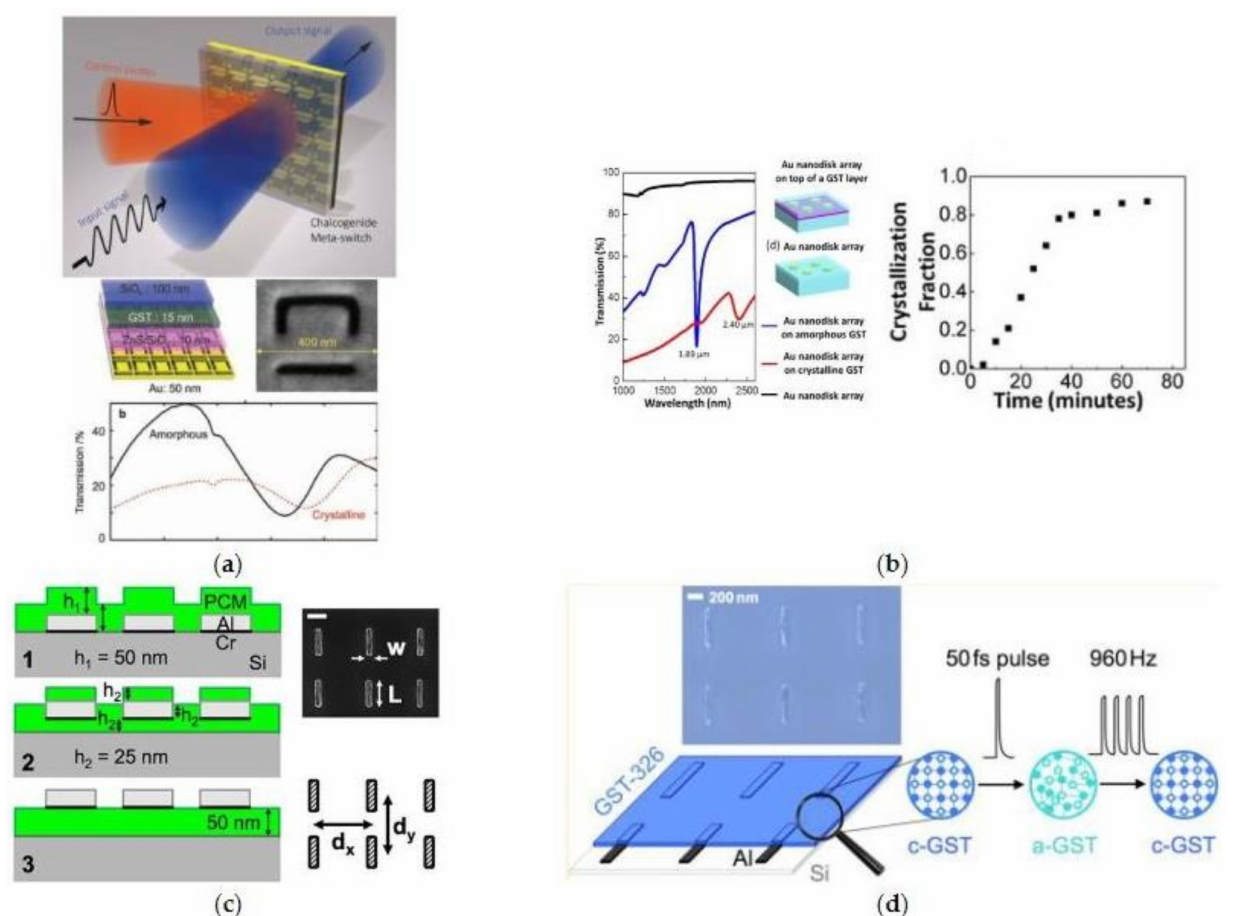
Figure 2. Early reported work on active metasurfaces with tunable amplitude transmission. ( a ) A near-IR all-optical meta-switch by integrating split ring resonators (SRR) meta-atoms with G 2 S 2 T 5 ; ( b ) the GST—Au hybrid plasmonic crystal with continuous transmission tuning by corresponding fractions of crystallization—( a , b ) are reproduced with permissions from [63,112], respectively; ( c , d ) switchable mid-IR antenna resonance using G 3 S 2 T 6 , reproduced with permission from